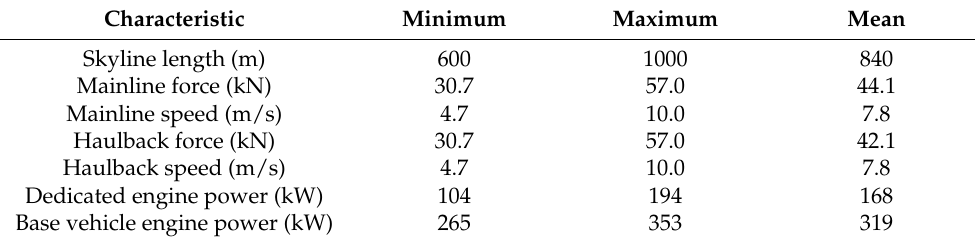
Table 1. Range of key performance characteristics of the TYs listed in Table